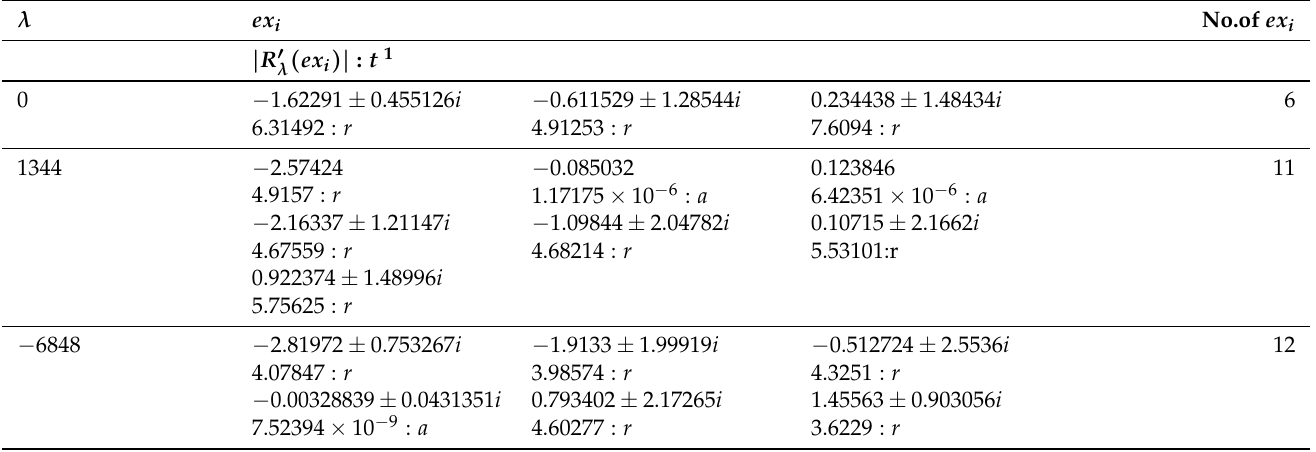
Table 1. Stability of strange fixed points ex i for special λ -values.